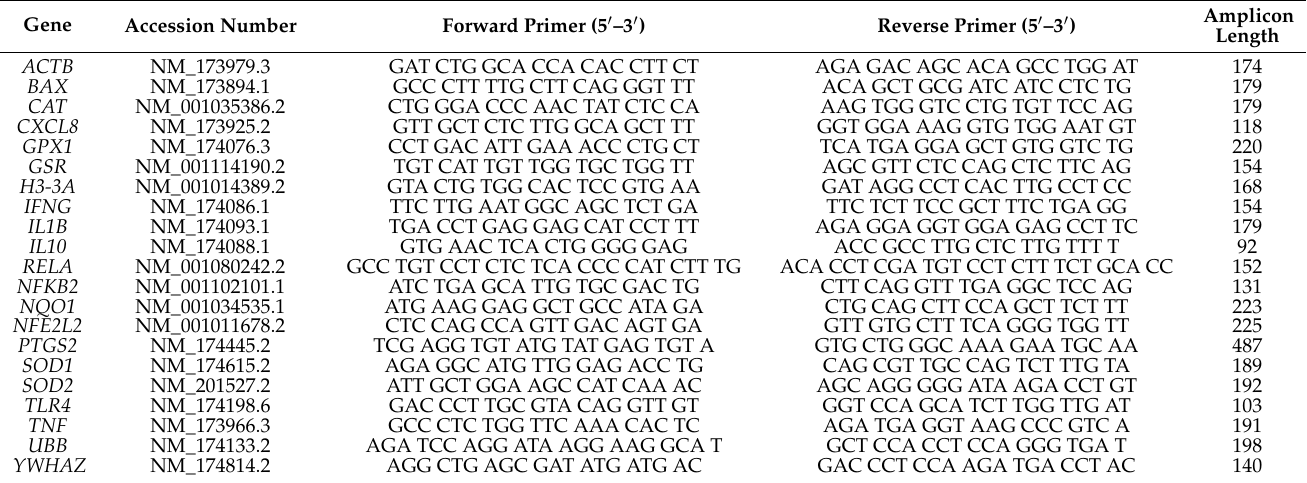
Table 2. Sequences of the primers used for qPCR in both experiments.